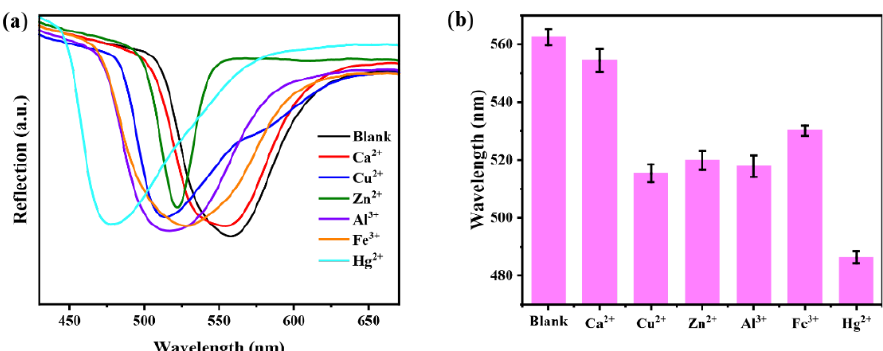
Figure 12. ( a ) UV-visible reflection spectra of CLC-PAA urease PC films with various metal ions (The films were treated with urea (10 mM) for 10 min); ( b ) The wavelength values of the reflected light of CLC-PAA urease PC films with various metal ions.